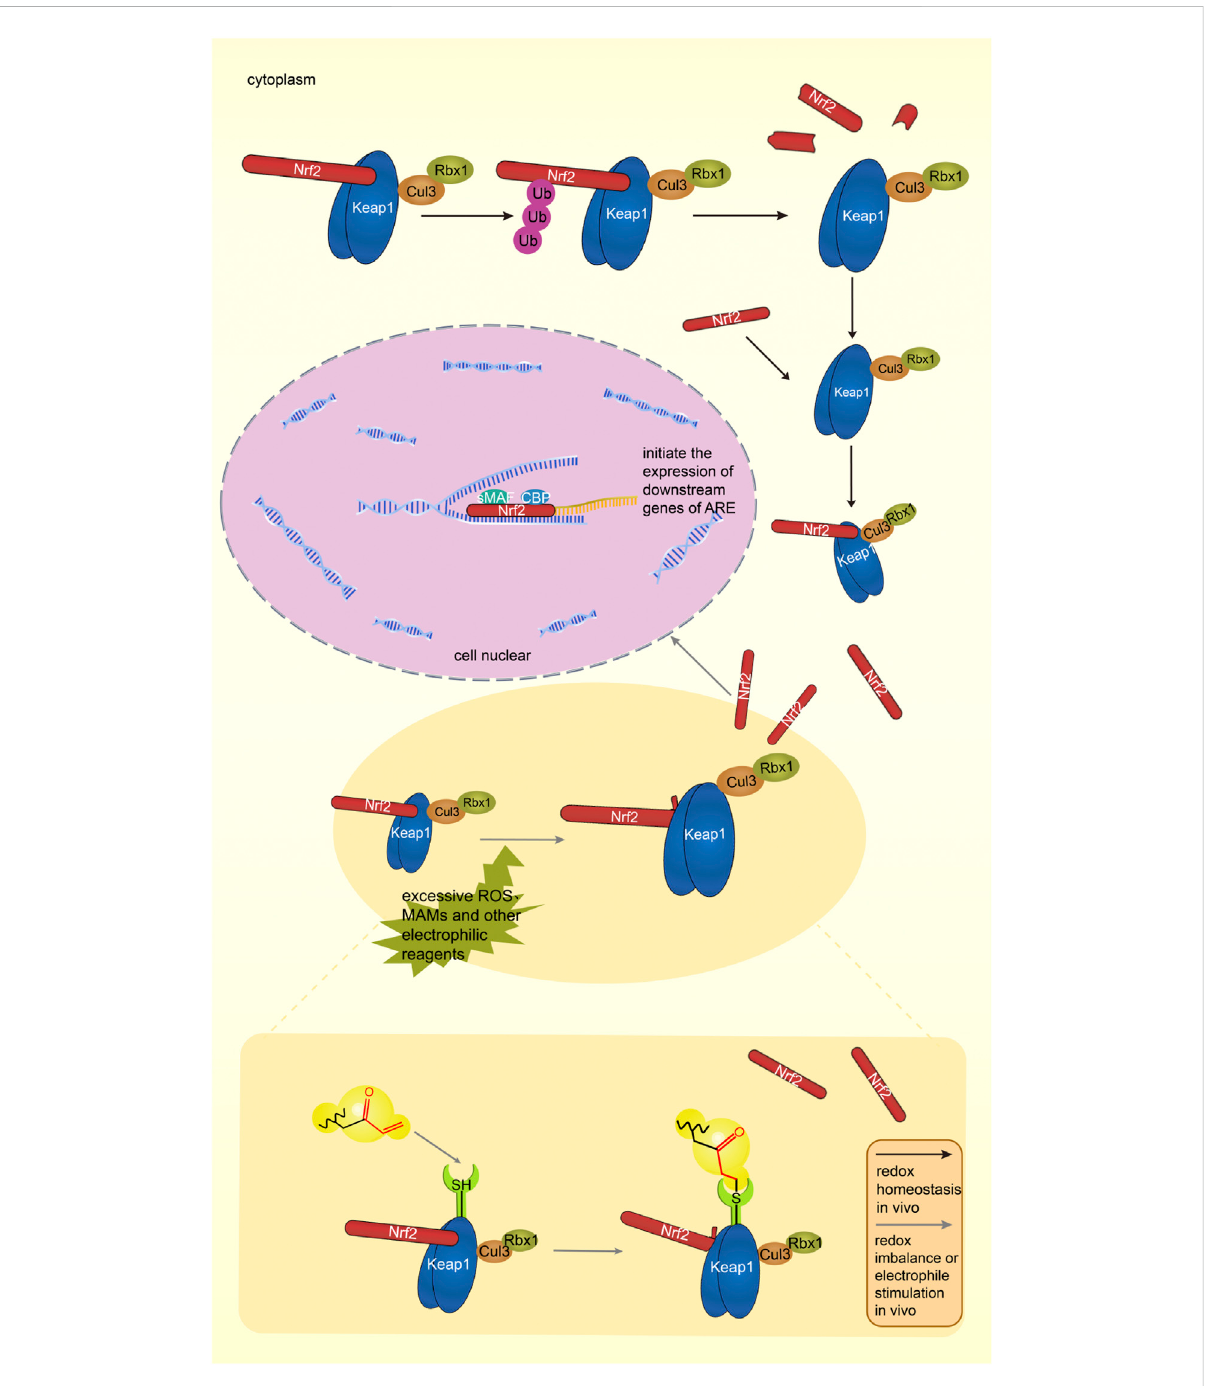
FIGURE 5 The Keap1-Nrf2-ARE pathway under physiological condition, Keap1 and Nrf2 form a complex in the cytoplasm, and Keap1 degrades Nrf2 throughtheproteasome pathway.The Keap1-Nrf2-ARE pathway inan activatedstate. Excessive ROS andelectrophilesincells leadto oxidative stress in the body. Nrf2 dissociates from Keap1, enters the nucleus, binds to ARE with sMAF and CBP, initiates the transcription of antioxidant genes, and induces the expression of antioxidant proteins. MAMs can target cysteine residues of Keap1, activate the Keap1-Nrf2-ARE pathway, and induce the expression of antioxidant proteins. Black arrows indicate normal physiological processes in the body. Gray arrows indicate the physiological process after MAMs react with thiol